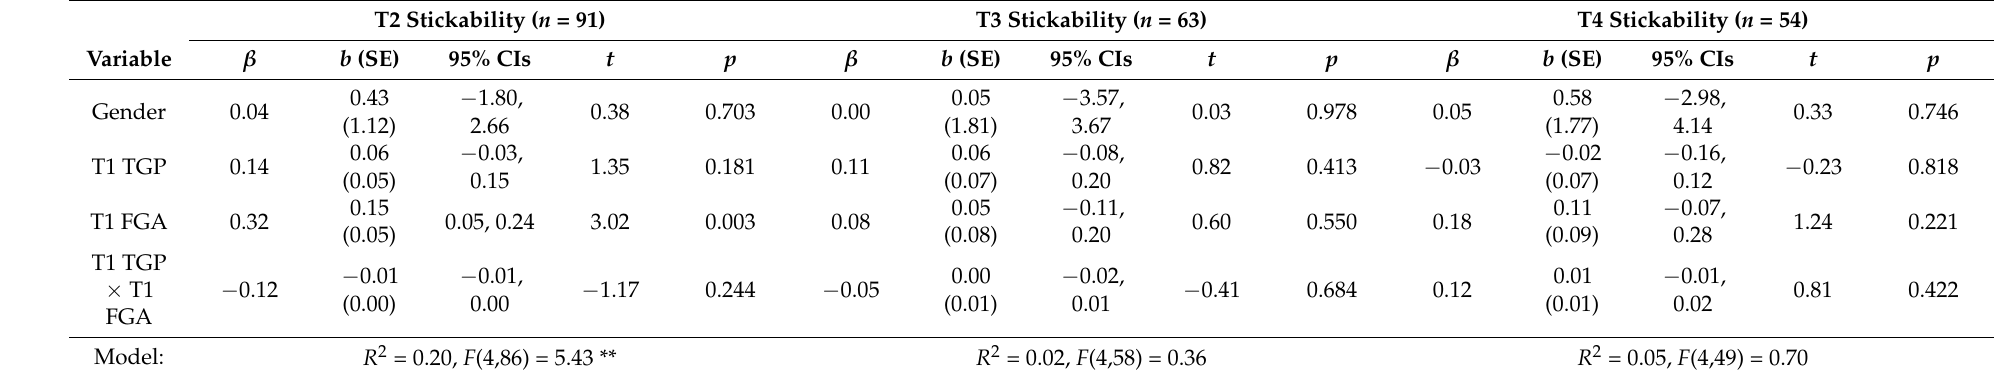
Table 3. Tenacious goal pursuit and flexible goal adjustment as predictors of T2 to T4 goal